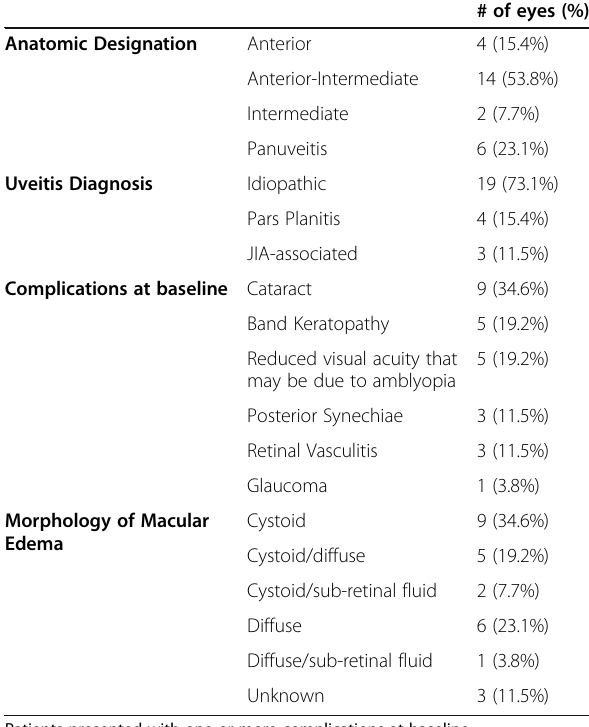
Table 2 Uveitis and Macular Edema Characteristics ( n = 26